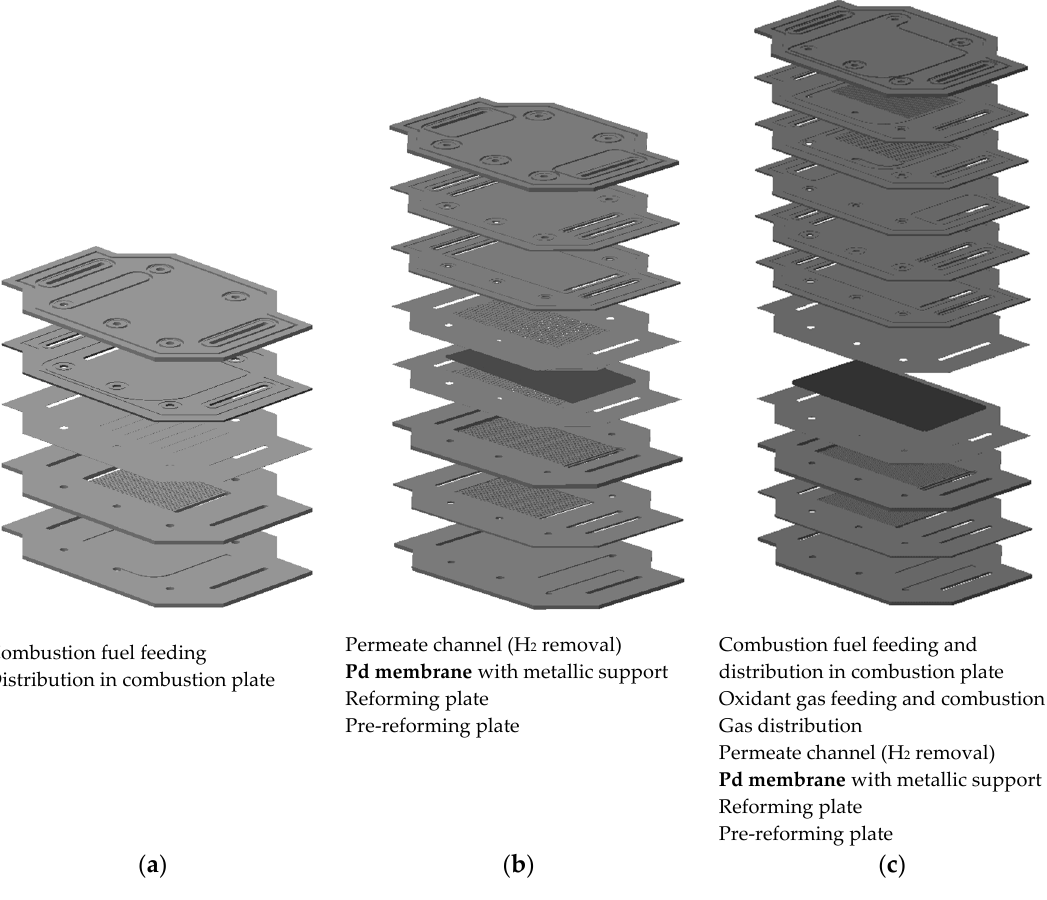
Figure 2. Stack designs for combustion, reformer, and integrated module for the reforming of methane with integrated hydrogen separation: ( a ) combustion; ( b ) reforming; ( c ) integrated.